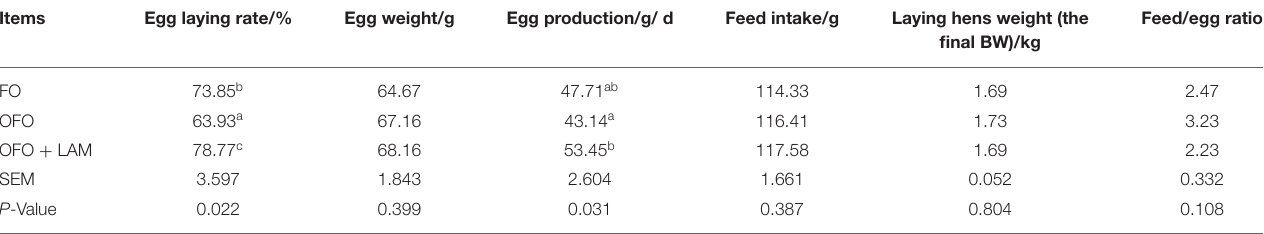
TABLE 2 | The effect of fish oil, oxidized fish oil, and oxidized fish oil with LAM on the reproductive performance of old laying hens.